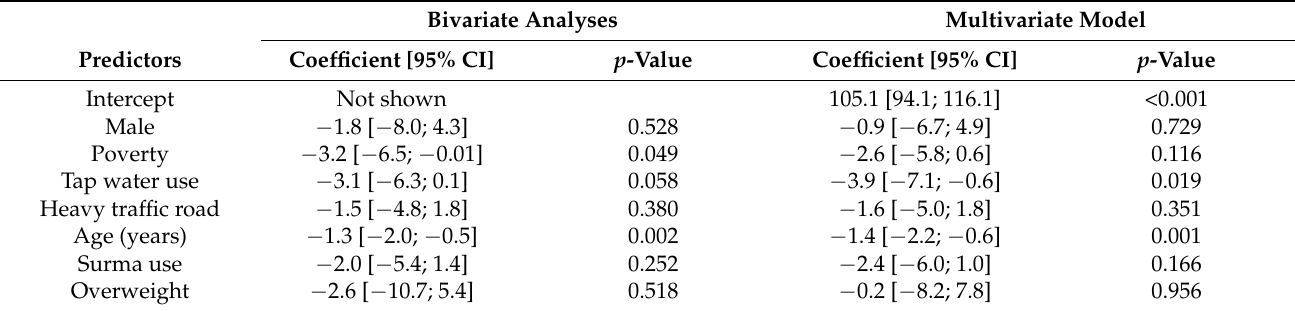
Table 2. Results from bivariate and multivariate analysis of children’s intellectual quotient with predictors. CI: Confidence